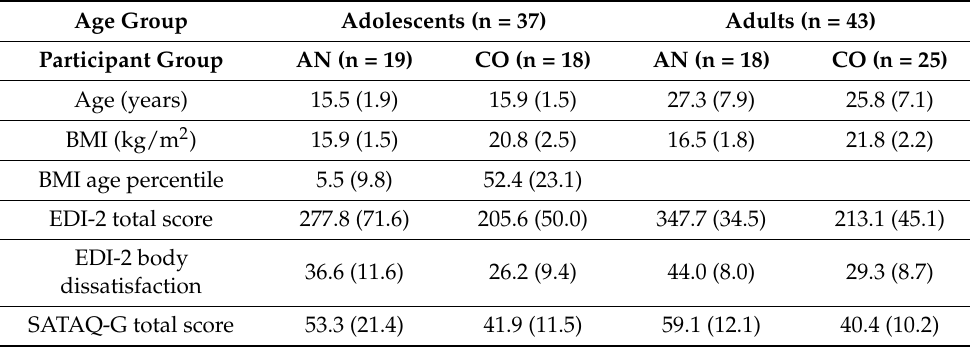
Table 1. Overview of sample characteristics (AN = anorexia nervosa patients, CO = control par- ticipants, n = partial sample size, M = mean, SD = standard deviation, BMI = body mass index, EDI-2 = Eating Disorder Inventory-2, SATAQ-G = German version of the Social Attitudes Towards Appearance